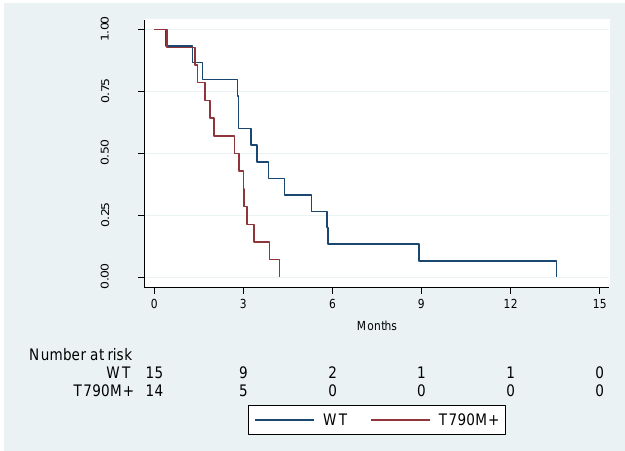
Figure 1. Kaplan-Meier survival estimates of progression free survival (PFS) of p.T790M negative (WT) and positive (T790M+) non-small-cell lung cancer (NSCLC) patients according to the droplet digital PCR (ddPCR) serum analysis.